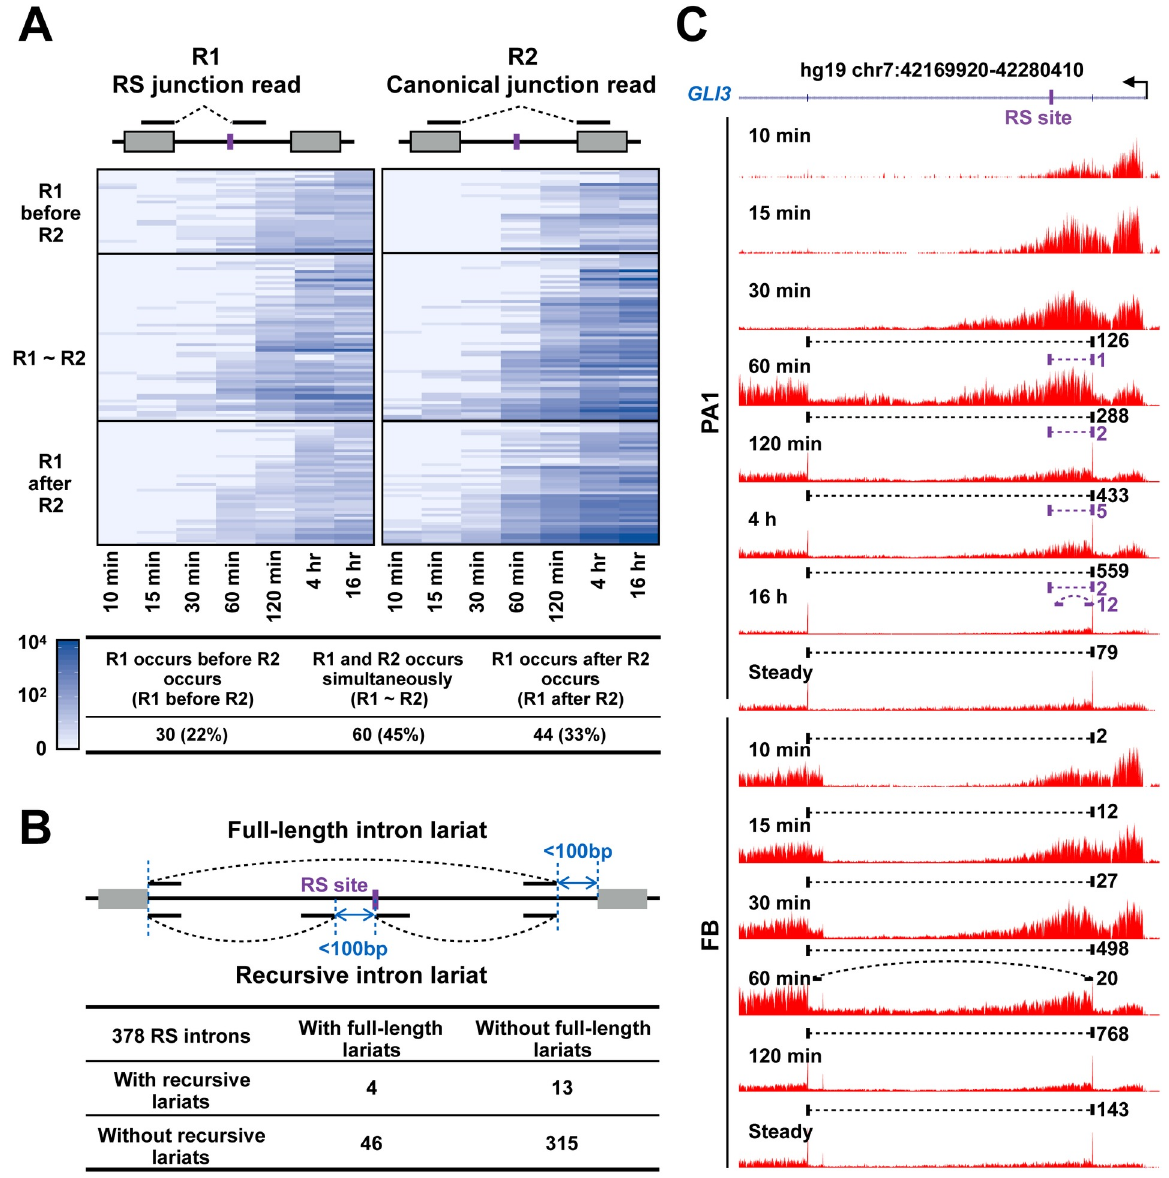
Fig 5. Recursive splicing is not constitutive and is cell-type specific. (A) Pairwise comparison of the occurrence of RS junction reads (R1) and canonical junction reads (R2) in RS introns. RS introns were classified into three group according to the appearance orders of R1 and R2. (B) Identification of full-length intron lariats (Materials and methods) in RS introns. (C) An example in the human GLI3 gene shows that recursive splicing is cell-type specific. Junction reads of recursive splicing (purple) or canonical splicing (black) are depicted as dashed straight lines, and lariats reads are depicted as dashed curved